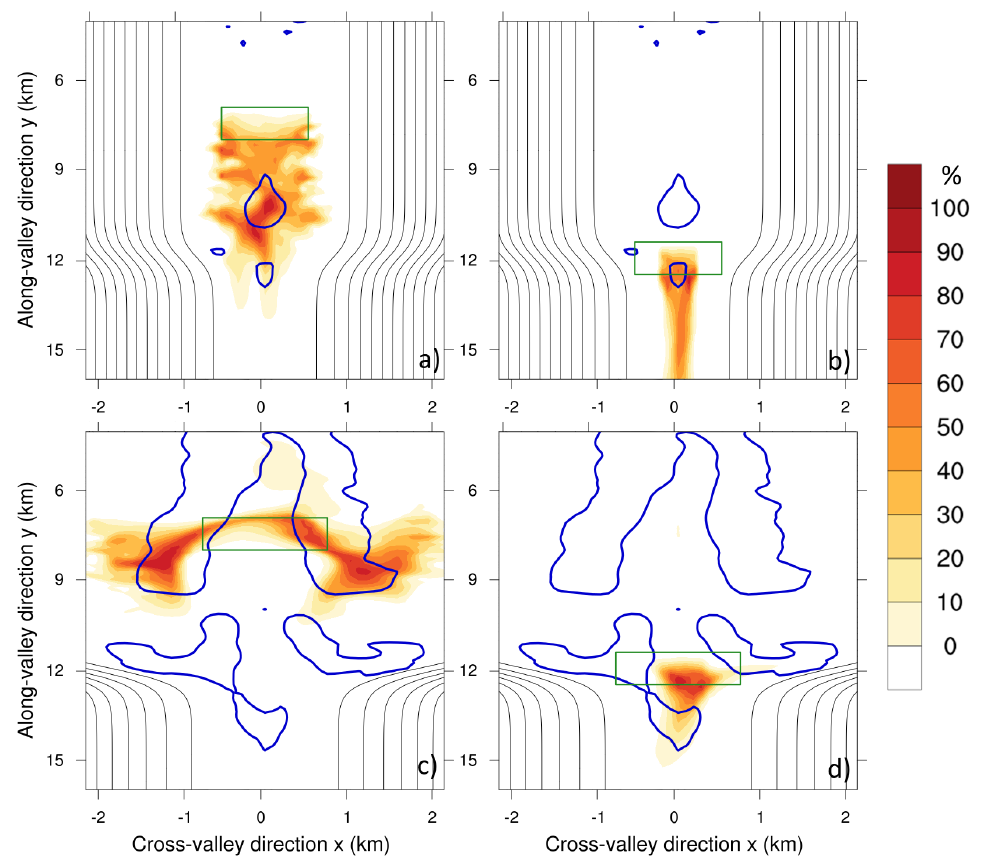
Figure 9. Contour plot of the normalized tracer concentration (percentage) at the end of the simulation (averaged over the last 15 min of simulation) overlaid over contour lines of the terrain height using 50 m intervals between them for ( a ) TrP 1 1 , ( b ) TrP 1 3 , ( c ) TrP 2 1 and ( d ) TrP 2 3 averaged over the first 30 m along the vertical. All figures are normalized with the maximum concentration for each of the tracers plotted, which is different in all the cases. Blue lines correspond to the locations where the critical stagnation zones are located (Figure 7e,f). Green rectangles represent the emission zones for each of the